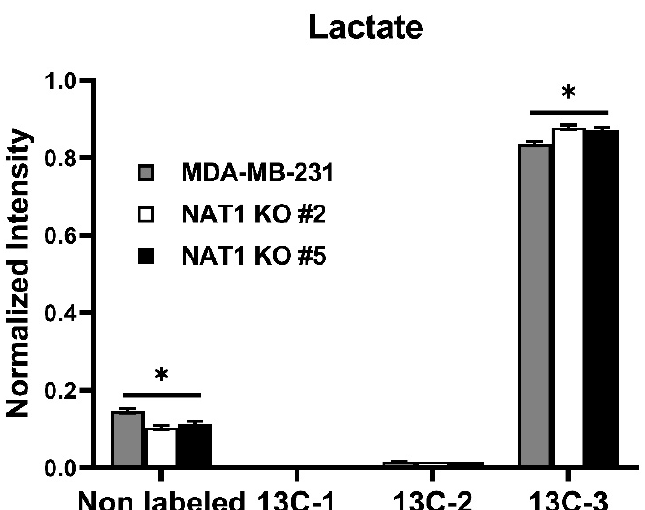
Figure 4. N -Acetyltransferase 1 Knockout E ff ect on the L -Lactate Levels of MDA-MB-231 Cells . Carbon-13 enrichment of L -Lactate was measured in MDA-MB-231 cells and NAT1 KO #2 and #5 after 24 h incubation with [ 13 C]-glucose. Data presented for both unlabeled [ 12 C] and detected [13C]-labeled metabolites ( 13 C-1, 13 C-2, and 13 C-3). Data represent the average of at least three experiments ± SEM, * q < 0.05 compared to